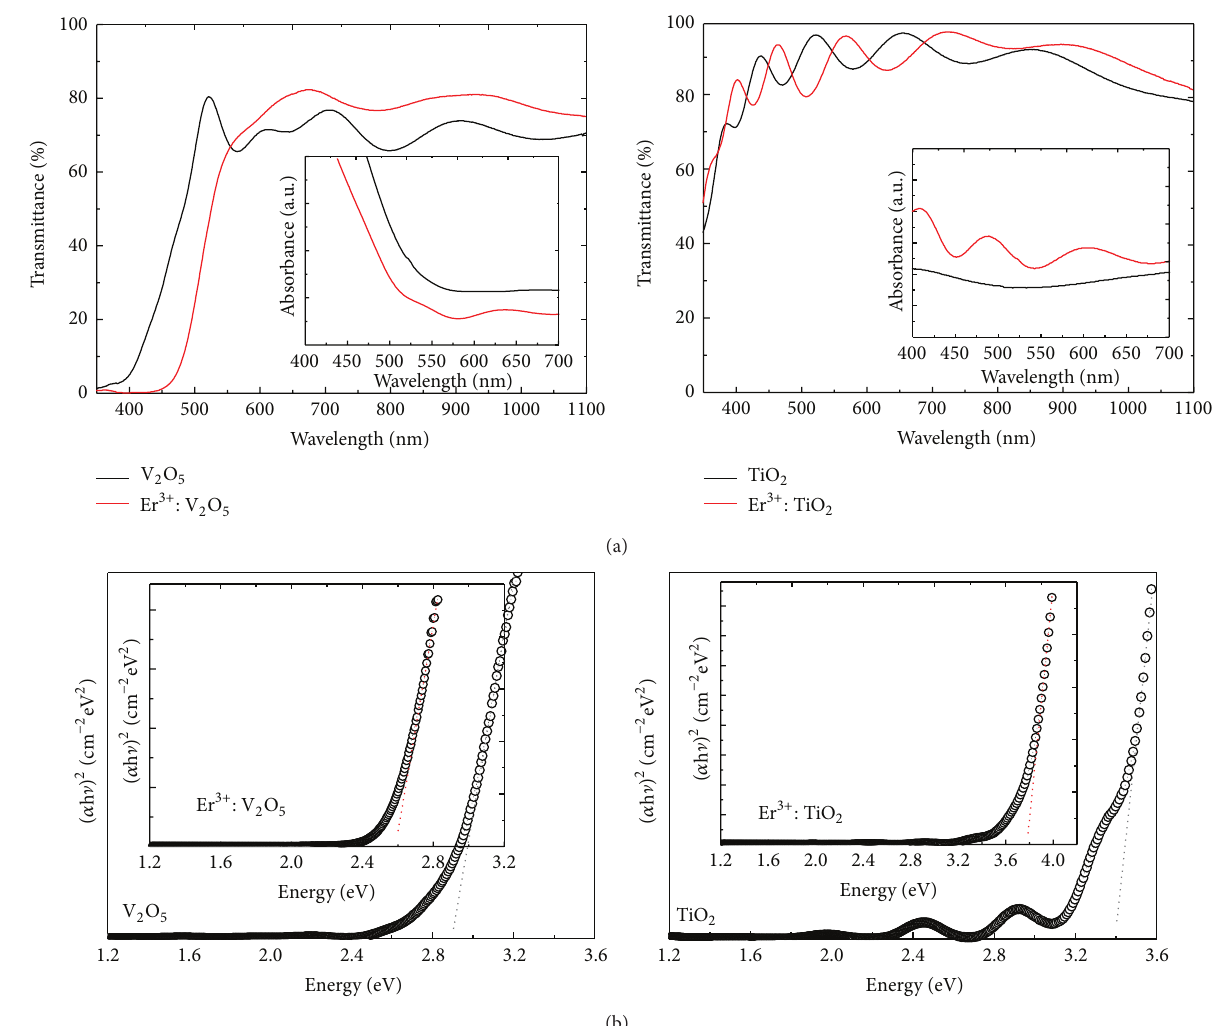
Figure 3: (a) Optical transmittance spectra, (b) Tauc plots of the films deposited on ITO coated glass substrates. The inset in (a) demonstrated the absorption measurement whereas in (b) resumed Tauc plot for Er-doped